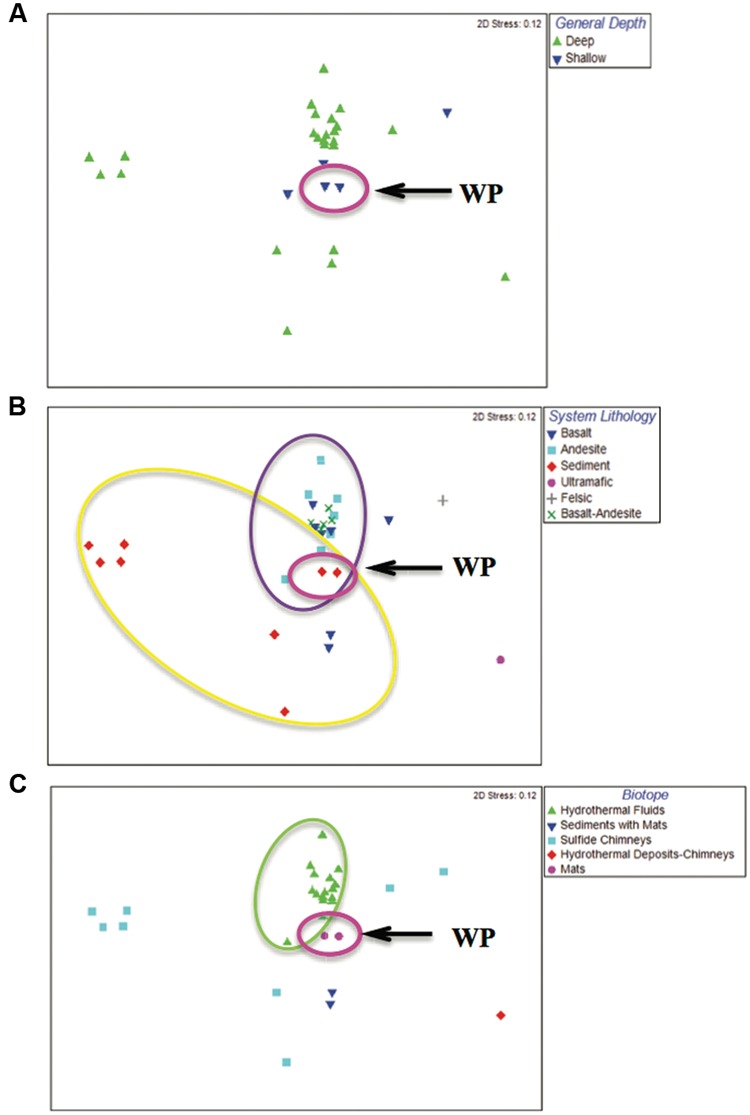
Multidimensional scaling (MDS) plots showing community variation, coded (colored symbols) according to depth, system lithology and biotope. Arrow and pink ellipse shows WP samples for all three panels, but does not denote statistical differences. (A) Depth. ‘Deep’ samples (>200 m) and ‘shallow’ samples (<200 m). (B) System lithology. Ellipses denote statistically significant communities as determined by ANOSIM (p < 0.005). Yellow denotes sediment-hosted sites; purple denotes Basalt, Andesite and Basalt-Andesite-hosted sites. (C) Biotope. Green ellipse denotes hydrothermal fluid sites that were significantly different from all others as determined by pair-wise ANOSIM comparisons (p < 0.01 for all).